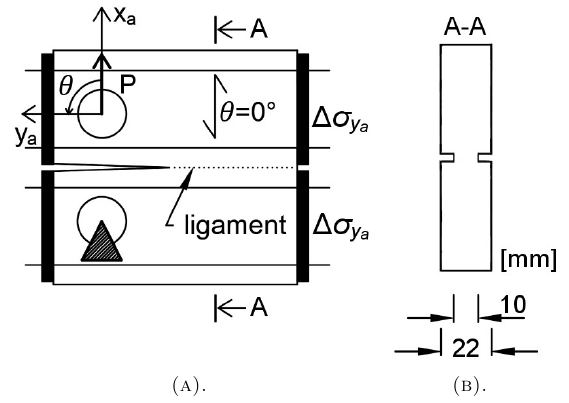
Figure 5. Pre-stressed compact tension (CT) test with the load-grain angle θ = 0°: configuration and dimensions. (A) Front view. (B) Side view. [3]